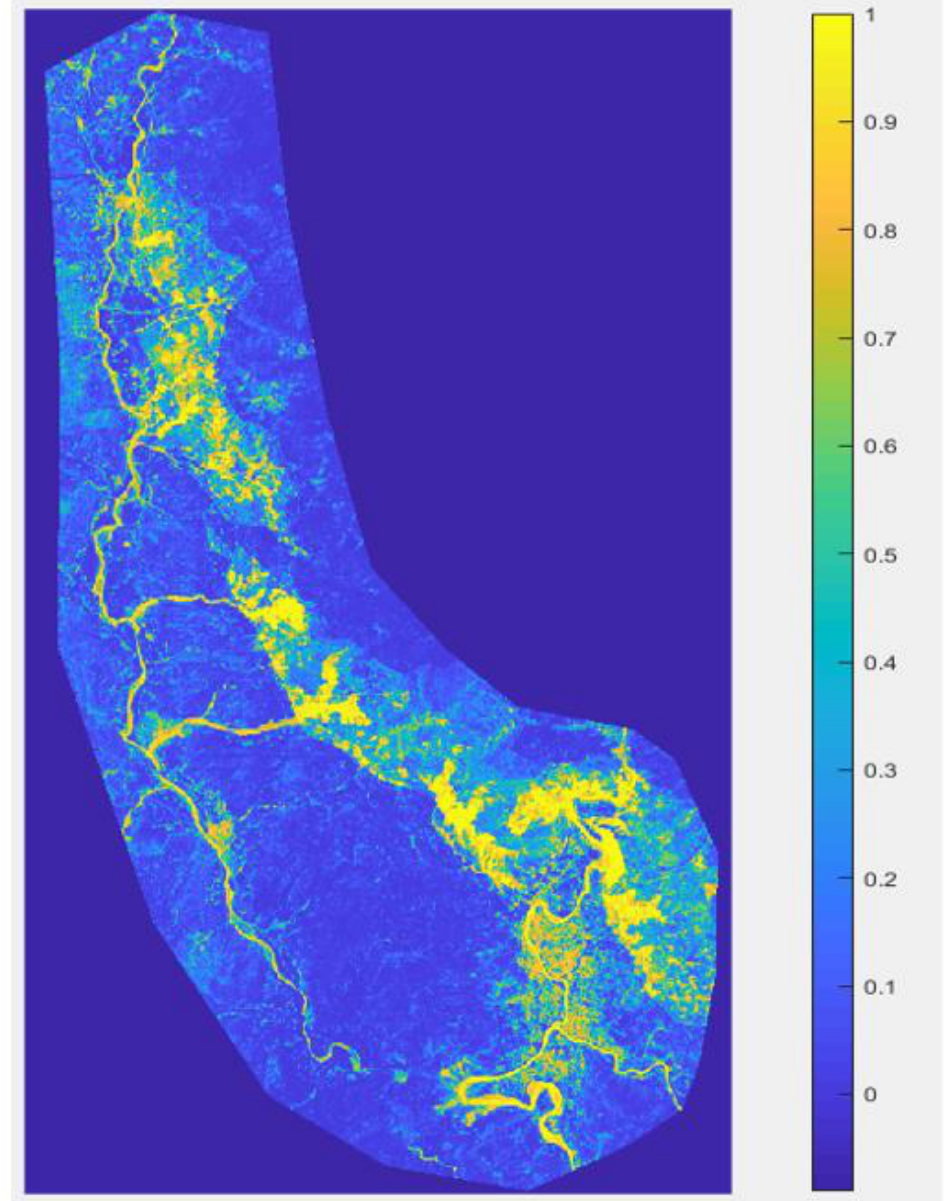
Figure 3: Landslide Susceptibility map derived from logistic regression